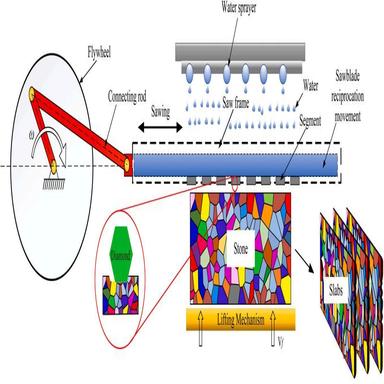
The schematic diagram of sawing stone into slabs by frame saw.